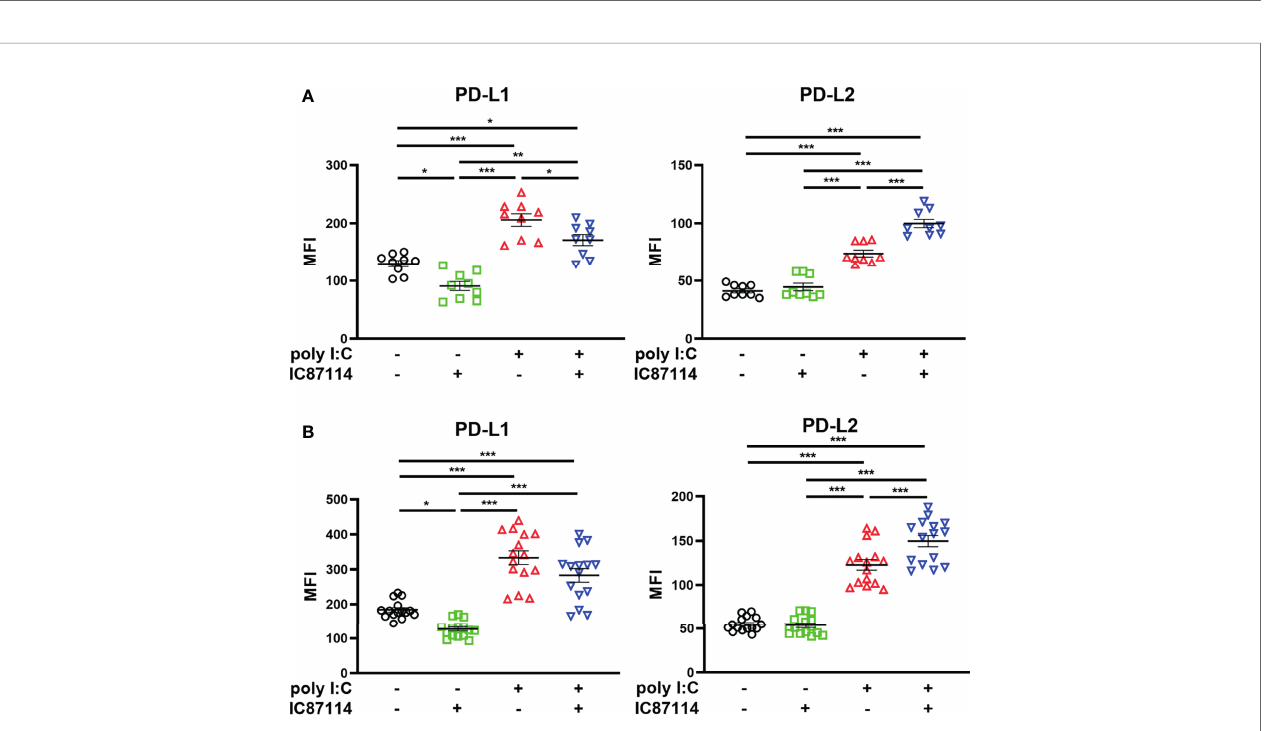
FIGURE 7 | The effects of a PI3K d inhibitor on poly I:C – induced PD-L1 and PD-L2 expression on PBECs from patients with asthma or COPD. PBECs from patients with asthma (A) or COPD (B) were pretreated with 10 m M IC87114 or vehicle for 1 h and then stimulated with 1 m g/mL poly I:C for 24 h. PD-L1 and PD-L2 expression on PBECs was analyzed using fl ow cytometry. Data represent means ± SEM (n=9 – 12 per group) and pooled from a minimum of three independent donors with three replicates. * p <0.05, ** p <0.01, *** p <0.001 by one-way ANOVA. MFI, mean fl uorescence